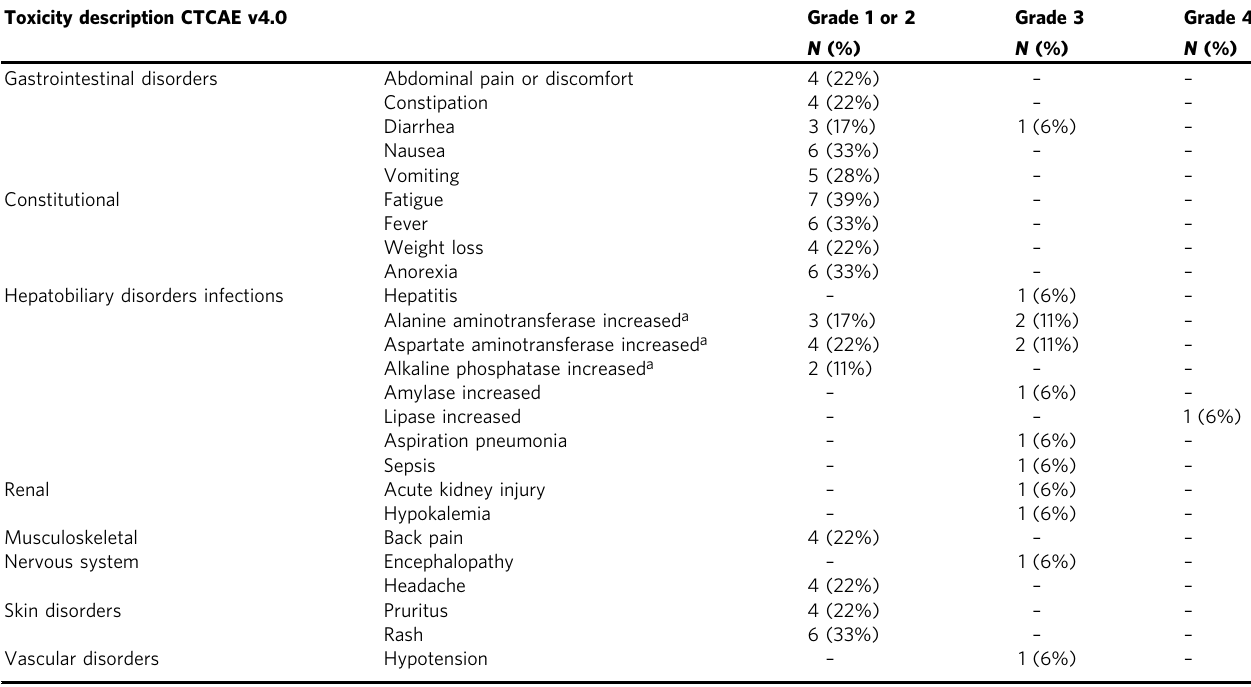
Table 4 Treatment-related events occurring in at least 15% of patients, all grade 3 or 4 toxicities and immune-related adverse